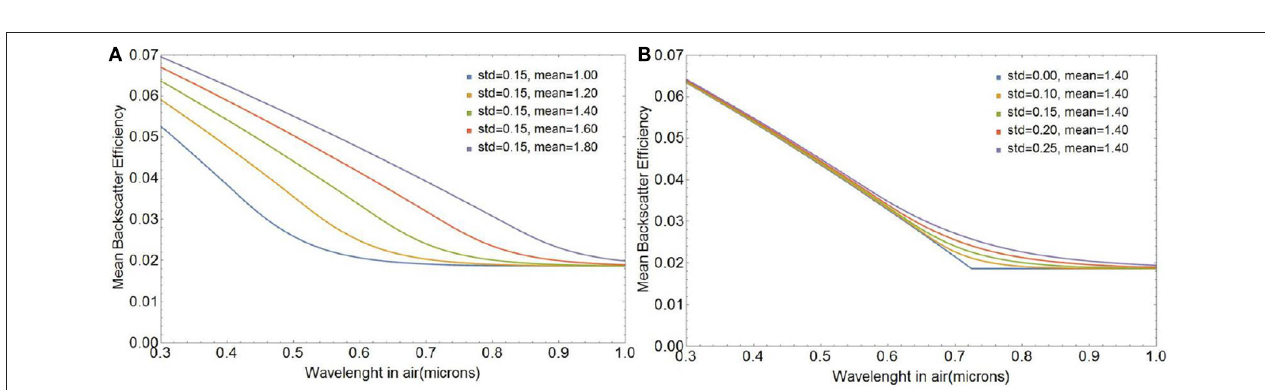
1 s gmin /1 s gmax . =